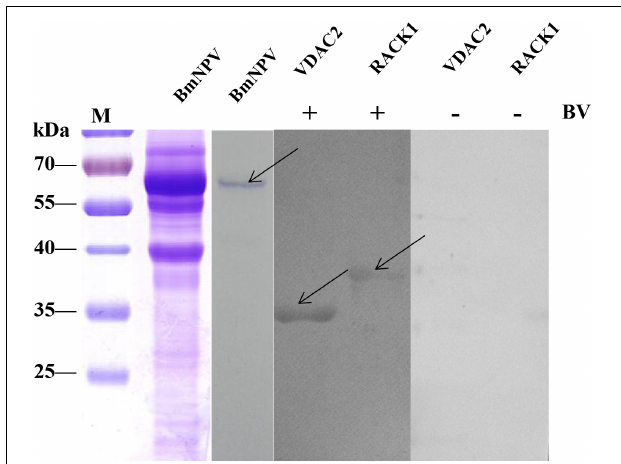
FIGURE 7 | Analysis of the interaction between BVs and recombinant proteins by far western blot. Purified recombinant proteins (RACK1 and VDAC2) were overlaid with BVs, and antibodies against AcMNPV gp64 protein were used to detect the BVs. BmNPV was used as a positive control. The negative overlay control consisted of binding buffer without BVs before incubation with monoclonal antibodies against AcMNPV gp64. The plus and minus signs on the top indicate membranes incubated with or without BVs, respectively. M, protein molecular weight marker.